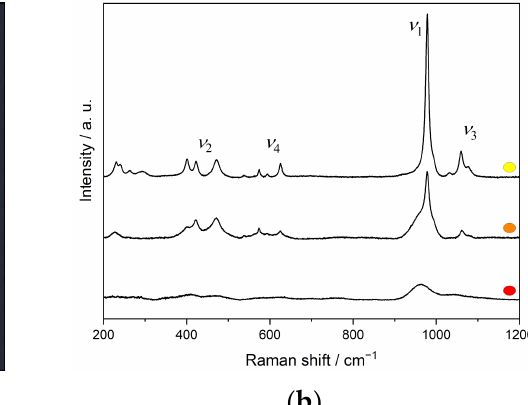
( b ) Figure 11. Raman spectra depicting the region of the stretching vibrations in unirradiated and Au ion irradiated FIB lamellae prepared from monazite-structured SmPO 4 , showing the broadening and shift of the symmetrical stretching vibration ν 1 with increasing fluence from F1 to F3 (( a ); cf., Figure 9), and for variable crystalline regions in the lamella irradiated at fluence F3 (( b ), cf., Figure 10) (Figs. reproduced from [56]). The radiation-induced changes in the length of the P–O bonds were estimated from the shift of the ν 1 band using the approach of Popovic et al. [97]. The red-shift of the ν 1